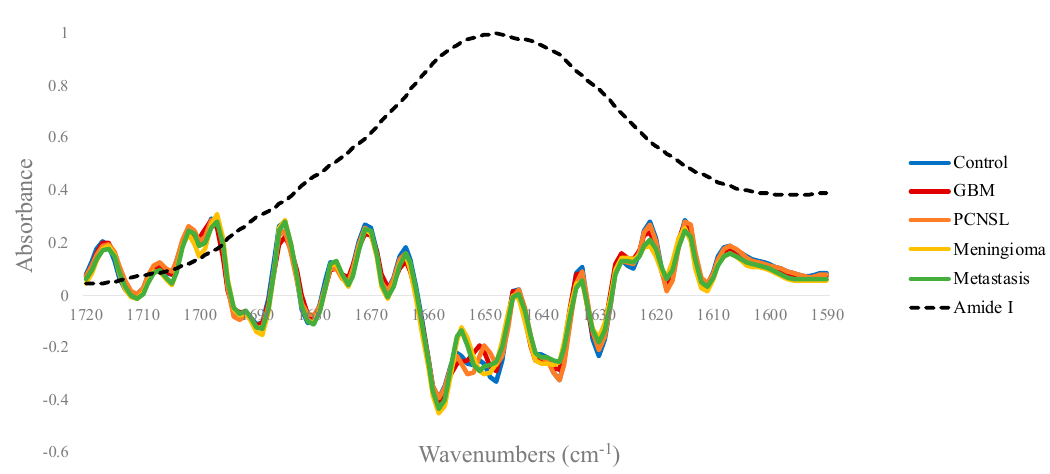
Figure 1. The mean second derivative spectra within the Amide I region (1720–1590 cm − 1 ) for the control, glioblastoma (GBM), primary central nervous system lymphoma (PCNSL), meningioma and metastasis patient groups.